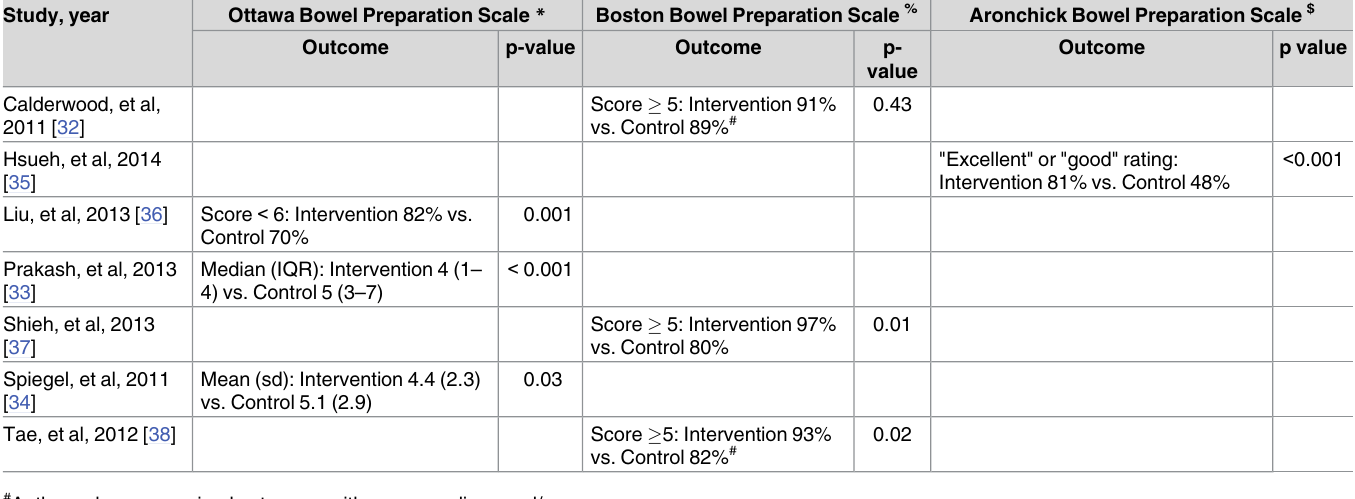
Table 3. Summary of primary outcomes for full-text studies by preparation